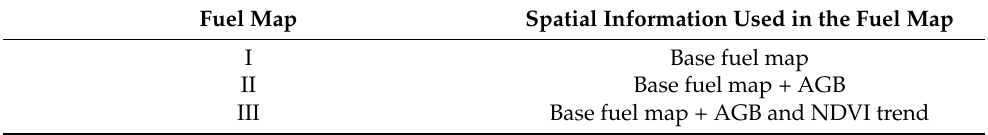
Table 2. The three fuel maps used in the WRF-Fire simulations. Fuel